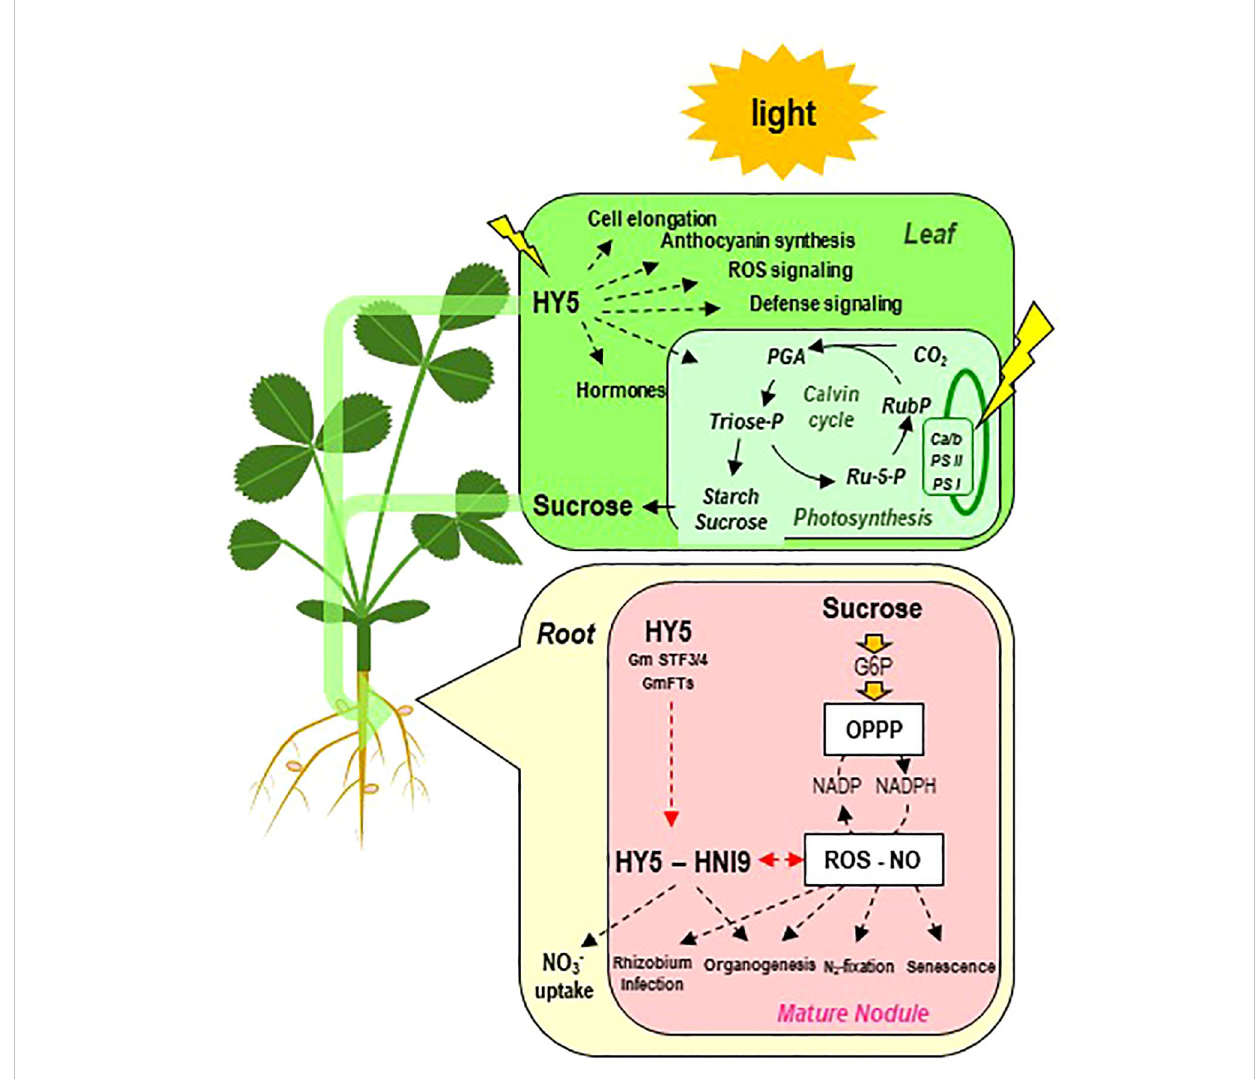
FIGURE 8 Schematic overview of the current knowledge of regulatory pathways potentially involved in the control of symbiosis by photosynthesis. On the one hand, sucrose resulting from photosynthesis is exported to the roots and the nodules. The fraction of sugars metabolized via the oxidative pentose phosphate pathway (OPPP) generates reducing power ( via the NADP/NADPH ratio), controlling the cellular redox state (ROS-NO). Redox state is involved in the regulation of many aspects of the establishment and the functioning of symbiosis. In the root, the redox state and the OPPP are also implicated in the regulation of NO 3 − transporters. On the other hand, in the leaves, the b-ZIP transcription factor ELONGATED HYPOCOTHYL 5 (HY5) is activated by light and regulates the assimilation and export of carbon to the root system. HY5 may translocate from shoots to roots via the phloem. In roots, HY5 together with the nuclear factor HIGH NITROGEN INSENSITIVE 9 (HNI9) activates the ROS detoxi fi cation program in connection with the cellular redox state and regulates downstream NO 3 − transporters and nodule organogenesis (in soybean). Ca/b, chlorophyll a/b binding complex; PS, photosystem; G6P, glucose-6-phosphate; NO, nitric oxide; OPPP, oxidative pentose phosphate pathway; PGA, 3- phosphoglycerate; phosphoglycerate; ROS, reactive oxygen species; Ru5P, ribose-5-phosphate; RubP,